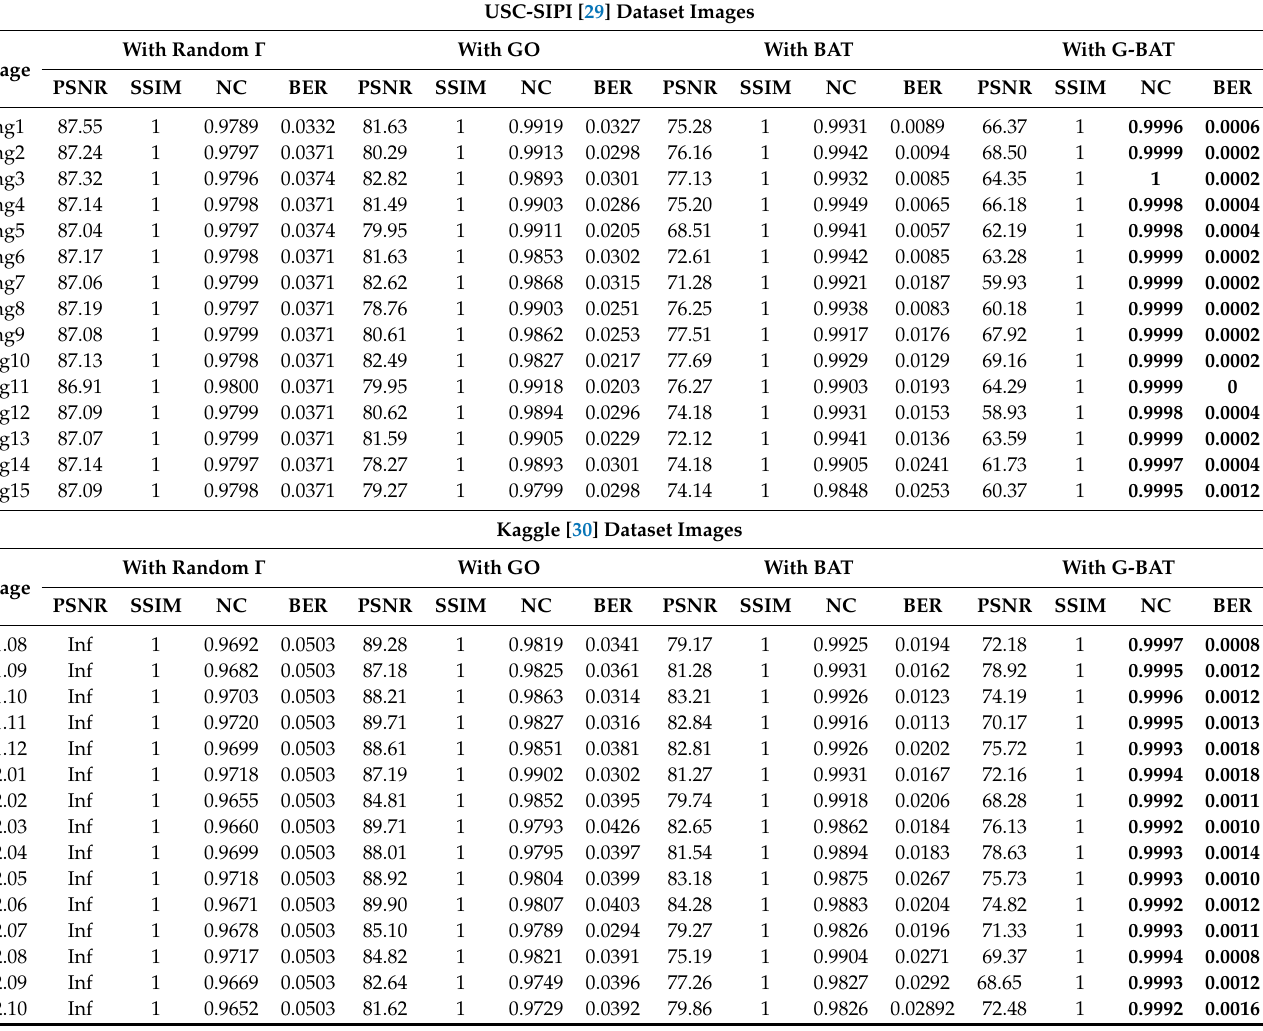
Table 3. PSNR, SSIM, NC and BER (under zero attack) with random Γ = 0.9 and Γ optimized using GO, BAT and G-BAT for 30 aerial RS (gray-scale and color) images taken from USC-SIPI [29] and Kaggle [30]